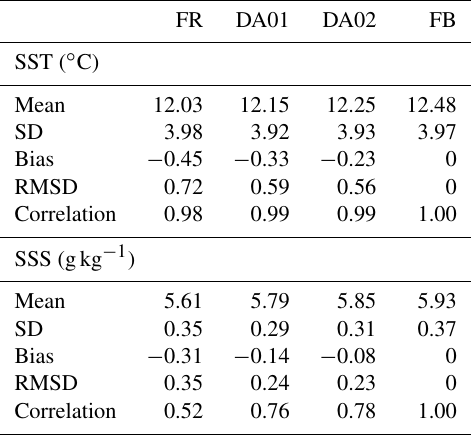
Table 2. Statistics of daily data in 0 . 5 × 1arcmin (N and E) grid cells with FerryBox (FB) observations: free model run without data assimilation (FR), data assimilation DA01 (observation weight 0.1), DA02 (weight 0.2) and FB. Bias, RMSD and correlation are taken with reference to